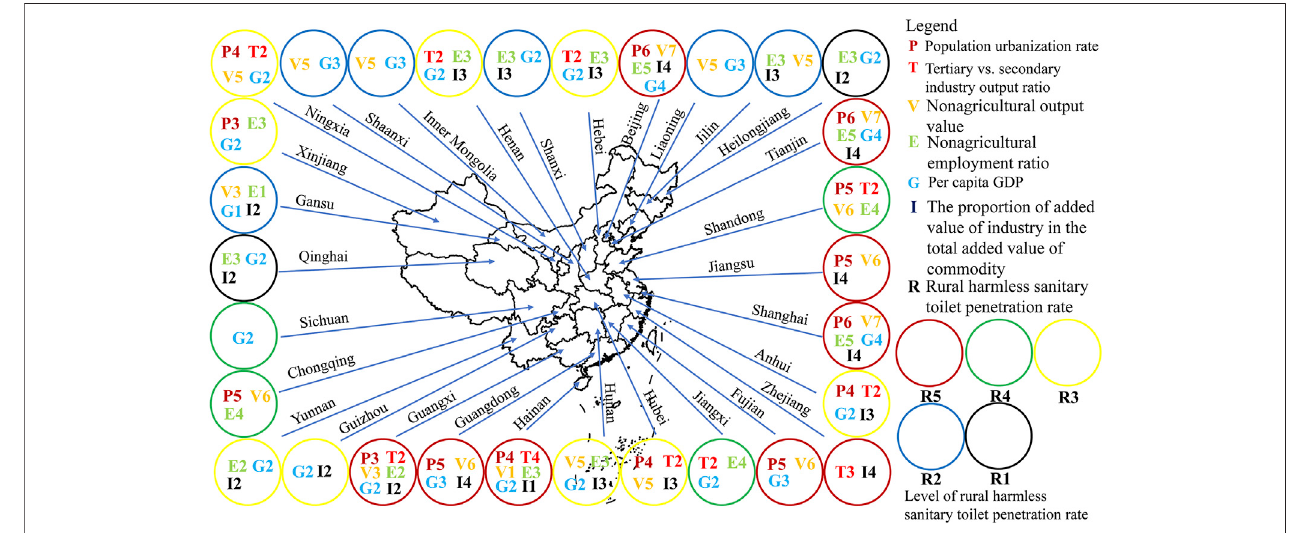
FIGURE 5 | SED indicators of regions associated with RHST penetration rate in